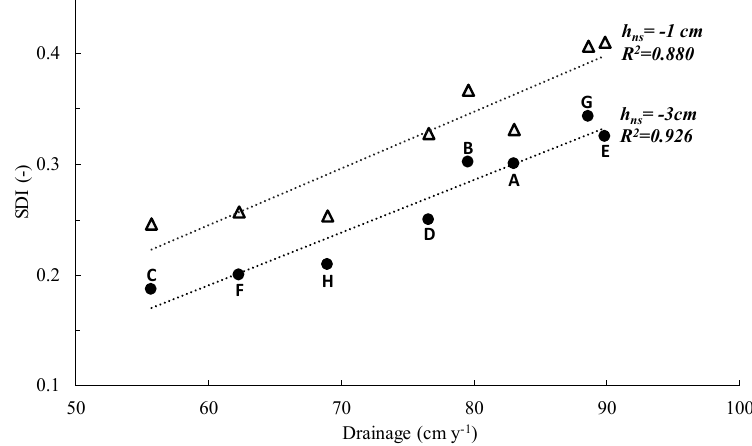
Figure 6. Soil drainage index (SDI) of each soil (A to H), calculated using h ns = − 1 cm or h ns = − 3 cm versus the average annual drainage under the bare soil (BS) scenario.